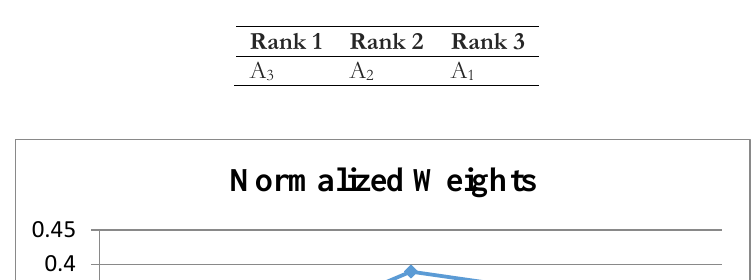
Table 11. Final VLAM ranking.